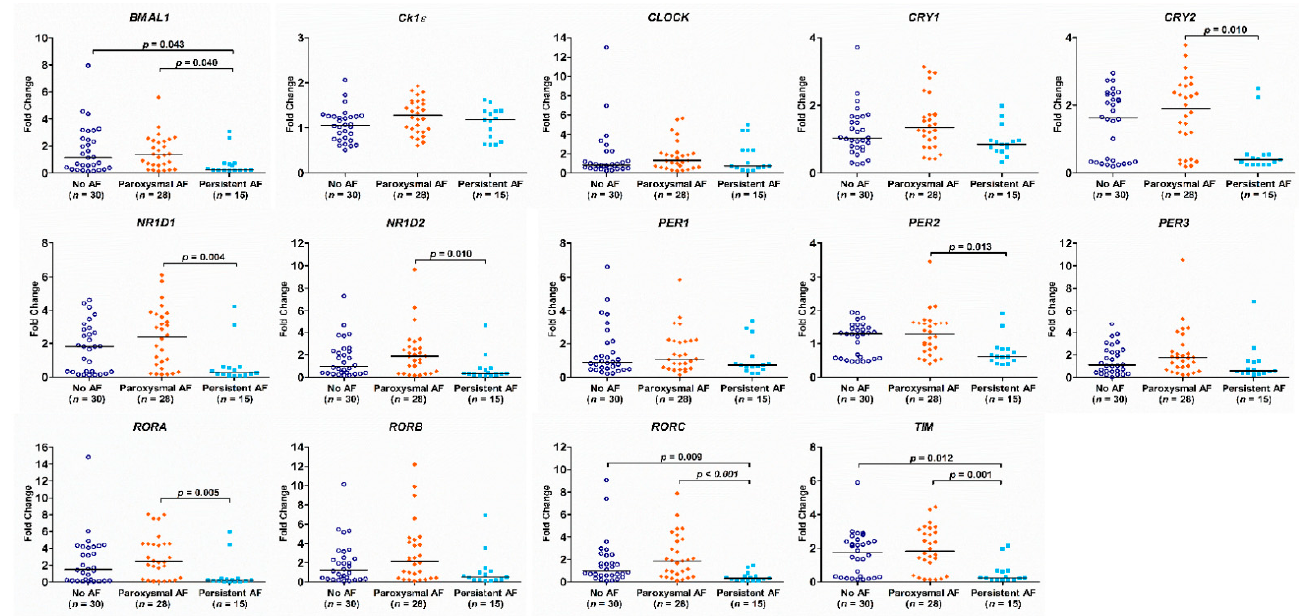
Figure 3. Expression of circadian clock genes in patients with persistent atrial fibrillation (AF), paroxysmal AF or no AF. The p -value analyzed by Kruskal–Wallis test followed by Dunn’s multiple comparison procedure indicates statistical significance as evaluated among patients with no AF ( n = 30), paroxysmal AF ( n = 28), and persistent AF ( n = 15) using ∆ Ct values.